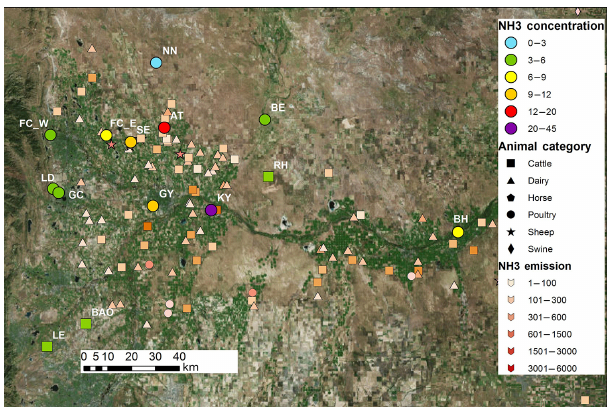
Figure 1. NH 3 concentrations (unit: µgm − 3 ) and feedlot emissions (unit: tyr − 1 ) in northeast Colorado. All sites indicated by circles include at least 3 years of measurements in summer. NH 3 concen- trations at the RH, LE, and BAO sites (squares) were only measured in the summers of 2010, 2011, and 2012, respectively. The predicted annual NH 3 emissions are calculated based on Eq.